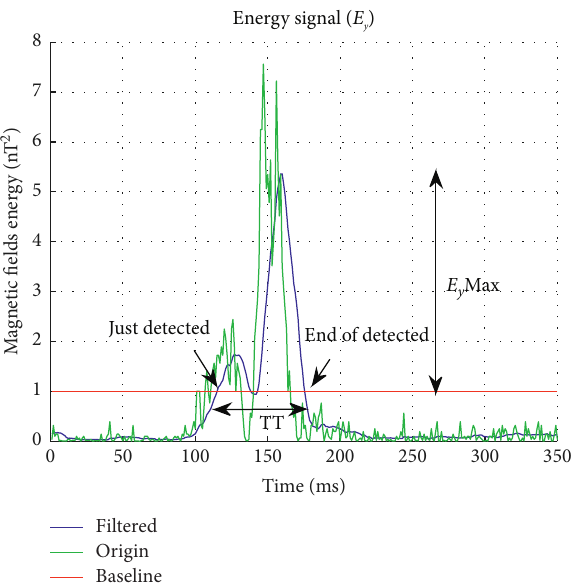
Figure 7: Vehicular detection marking its start and end, E and